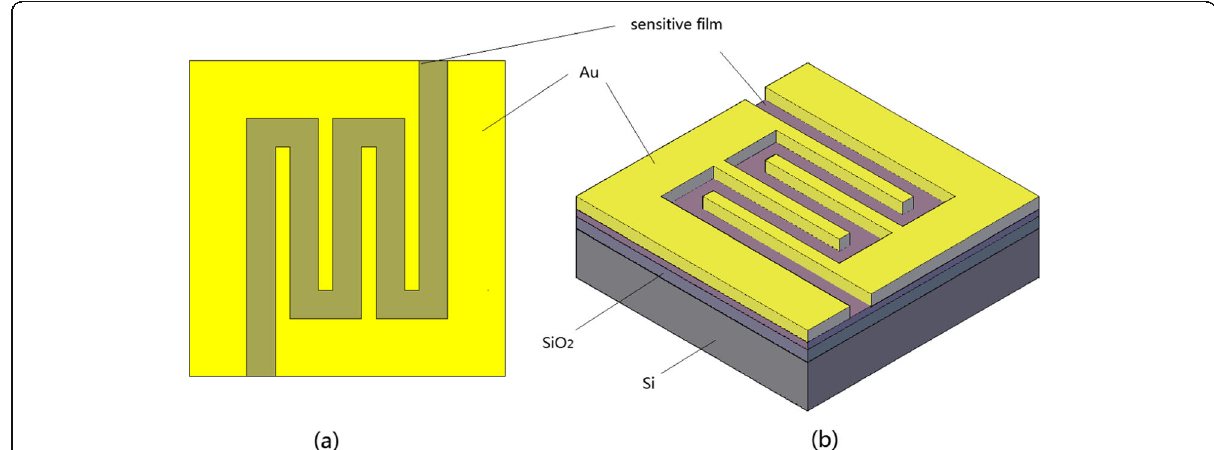
Fig. 1 Schematics of a top view of gas sensor and b stereogram of gas